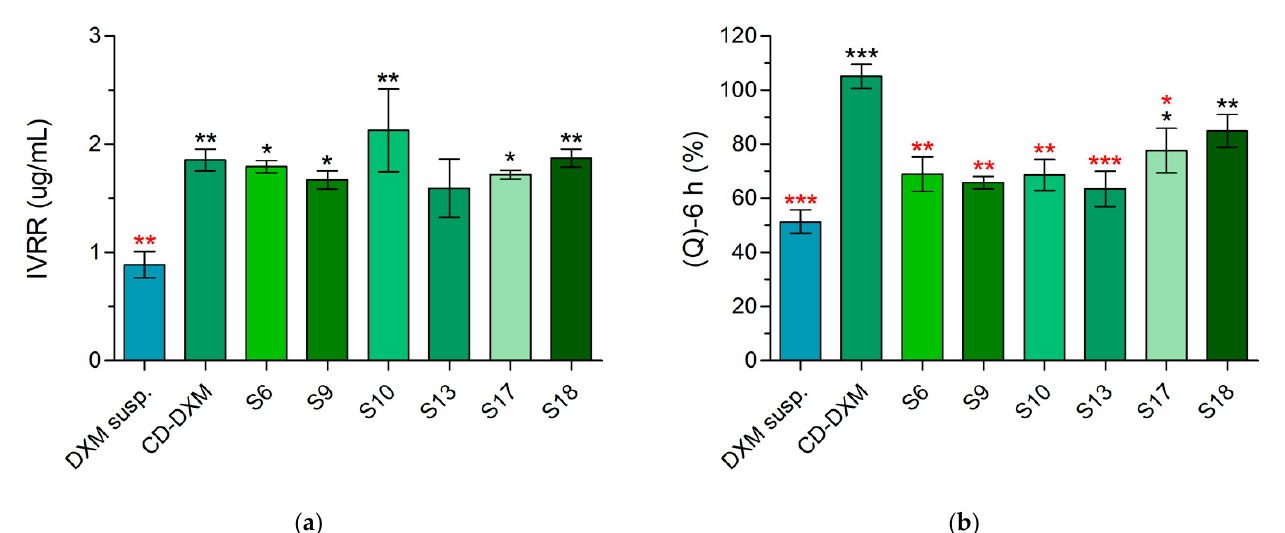
Figure 10. Comparison of in vitro drug release parameters of optimal formulations with DXM suspension. Statistical analysis: one-way ANOVA followed by Dunnett’s test. (* p ≤ 0.05 signif- icant; ** p ≤ 0.01 very significant; *** p ≤ 0.001 highly significant difference. The difference from DXM suspension is indicated with black, the difference from CD-DXM solution is indicated with red). ( a ) Release efficiency of DXM suspension, CD-DXM solution and in situ gelling formulations. ( b ) In vitro release rate of DXM suspension, CD-DXM solution, and in situ gelling